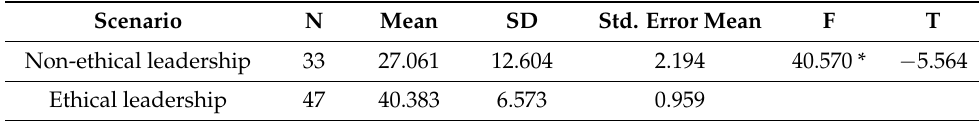
Table 2. t -test and Independent Samples test (for manipulation